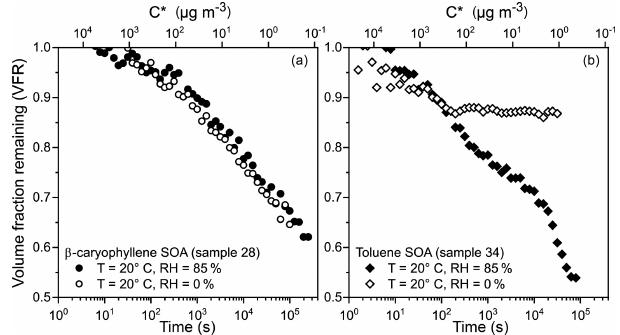
Figure 8. Volume fraction remaining (VFR) for single β - caryophyllene SOA (a) and toluene SOA (b) droplets confined in an electrodynamic balance (EDB) over ∼ 1d. VFR is compared for evaporation into high RH (solid symbols) and dry conditions (open symbols). Sample numbers correspond to the experiments shown in Table 1. The secondary x axis displays the calculated effective satu- ration concentration ( C ∗ , µgm − 3 ); see text for further